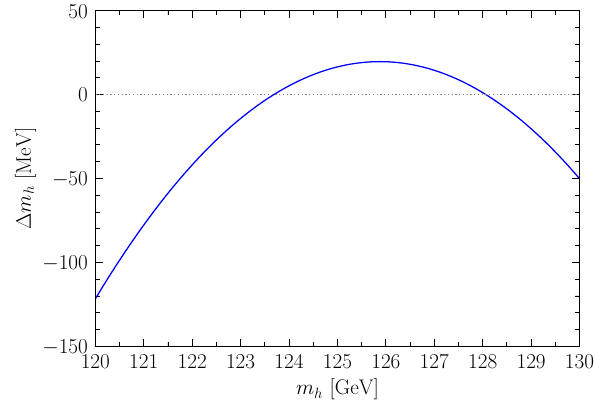
Fig. 1 Difference (in MeV) between the Higgs mass given as input to the code mr and the Higgs mass obtained by inserting in Eq. (34) the value of λ( m t ) computed by mr , as a function of the input Higgs